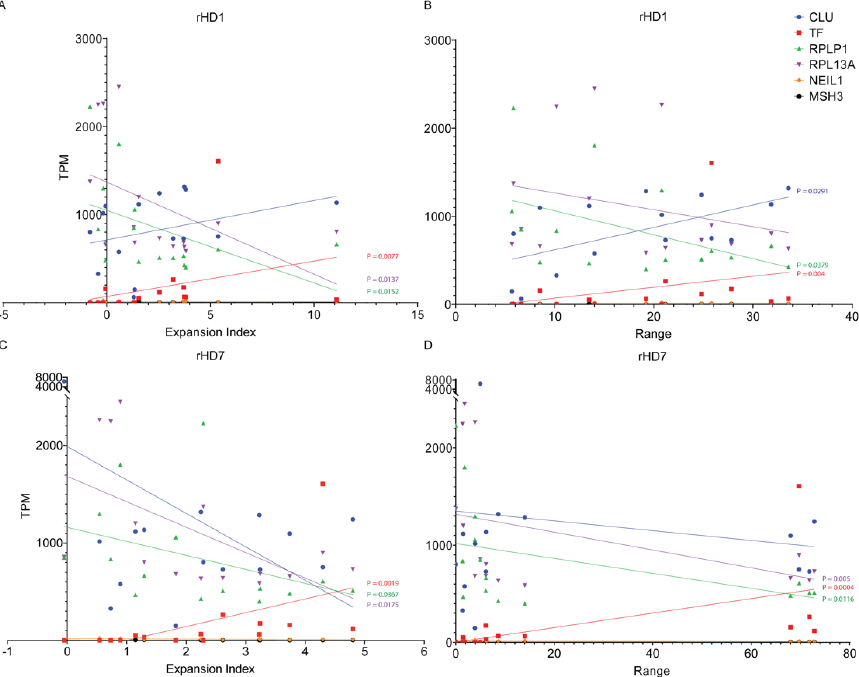
Figure 6. Correlation of gene expression in tissue samples used in this study against expansion index and curve-fit data. ( A ) A Spearman’s correlation analysis of rHD1 data showed a strong positive correlation between expansion index and TF expression in rHD1, which was statistically significant (R s (14) = 0.6214, p = 0.0077) while CLU showed positive correlation that was close to statistical sig- nificance (R s (14) = 0.4321, p = 0.0547). RPLP1 and RPL13A expression levels showed a statistically significant strong negative correlation with the expansion index ((R s (14) = − 0.5750, p = 0.0137) and (R s (14) = − 0.5648, p = 0.0152), respectively). NEIL1 and MSH3 did not show any significant correla- tion. ( B ) The Spearman’s correlation showed a strong positive correlation between range of the curve fit data with CLU and TF expression, which was statistically significant ((R s (14) = 0.5036, p = 0.0291) and (R s (14) = 0.6679, p = 0.004), respectively). RPLP1 expression level showed a statistically significant strong negative correlation with the expansion index (R s (14) = − 0.4750, p = 0.0379). RPL13A, NEIL1, and MSH3 did not show any significant correlation. ( C ) The Spearman’s correlation of rHD7 expansion index data showed a statistically significant positive correlation between expansion index and TF expression (R s (14) = 0.7143, p = 0.0019) while no significant correlation was observed with CLU expression (R s (14) = 0.3214, p = 0.4566). Both RPLP1 and RPL13A showed statistically significant negative correlations ((R s (14) = − 0.4786, p = 0.0367) and (R s (14) = − 0.5523, p = 0.0175), respectively). No significant correlation was found for both NEIL1 and MSH3. ( D ) When a Spearman’s correlation was analyzed with range of curve-fit data and gene expression, similar correlation trends were observed as expansion index. A statistically significant positive correlation between curve-fit range and TF expression (R s (14) = 0.7893, p = 0.0004) was observed while no significant correlation was observed with CLU expression (R s (14) = 0.3607, p = 0.0935). Both RPLP1 and RPL13A showed a statistically significant negative correlation ((R s (14) = − 0.5893, p = 0.0116) and (R s (14) = − 0.6524, p = 0.005), respectively). No significant correlation was found for both NEIL1 and MSH3.